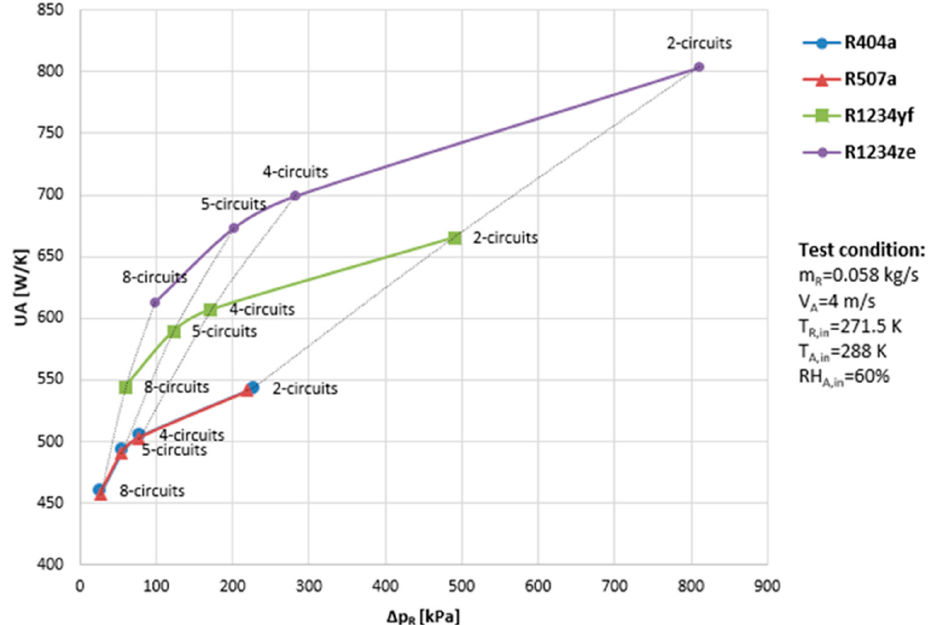
Figure 19. Impact of number of circuits on UA factor and refrigerant pressure drop for refrigerants R507a, R404a, R1234yf, and R1234ze [89]. The gray lines represent the junctions between points with the same number of circuits.